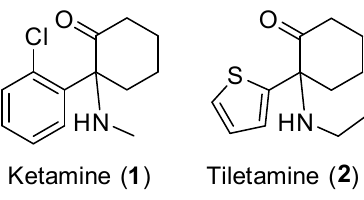
Figure 1. Ketamine, tiletamine.